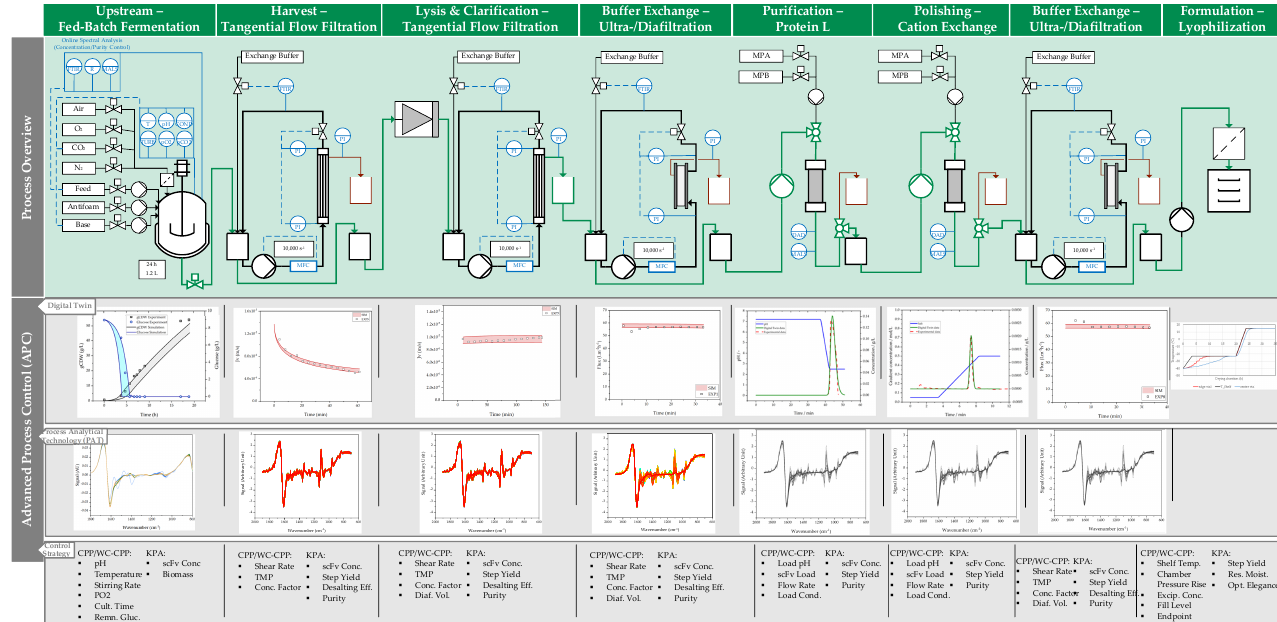
Figure 12. Process flowsheet including APC by Digital Twins and optimized PAT. Critical Process Parameter (CPP), Well-Controlled Critical Process Parameter (WC-CPP), Key Process Attribute (KPA), Particle Size Distribution (PSD), Viable Cell Density (VCD), Transmembrane Pressure